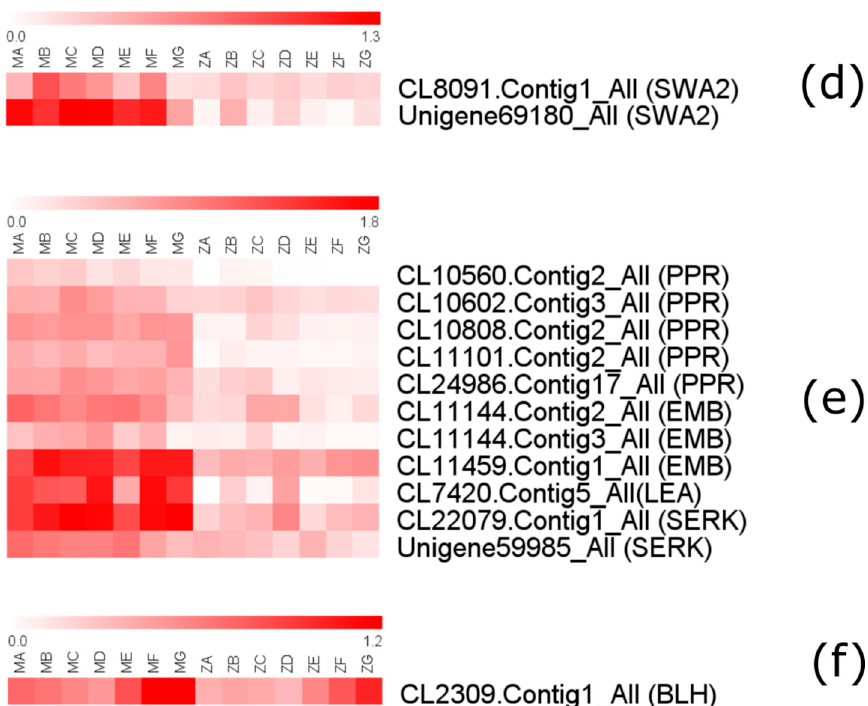
Figure 9. Expression levels of DEGs related to the reproductive process at successive pinecone developmental stages of P. massoniana and the Z pine. Expression level values in this figure have been transformed to a log 10 (FPKM+1) value. ( a ) pollen development; ( b ) pollen exine formation; ( c ) pollen tube growth; ( d ) female gametophyte; ( e ) embryo development; ( f ) embryo sac.